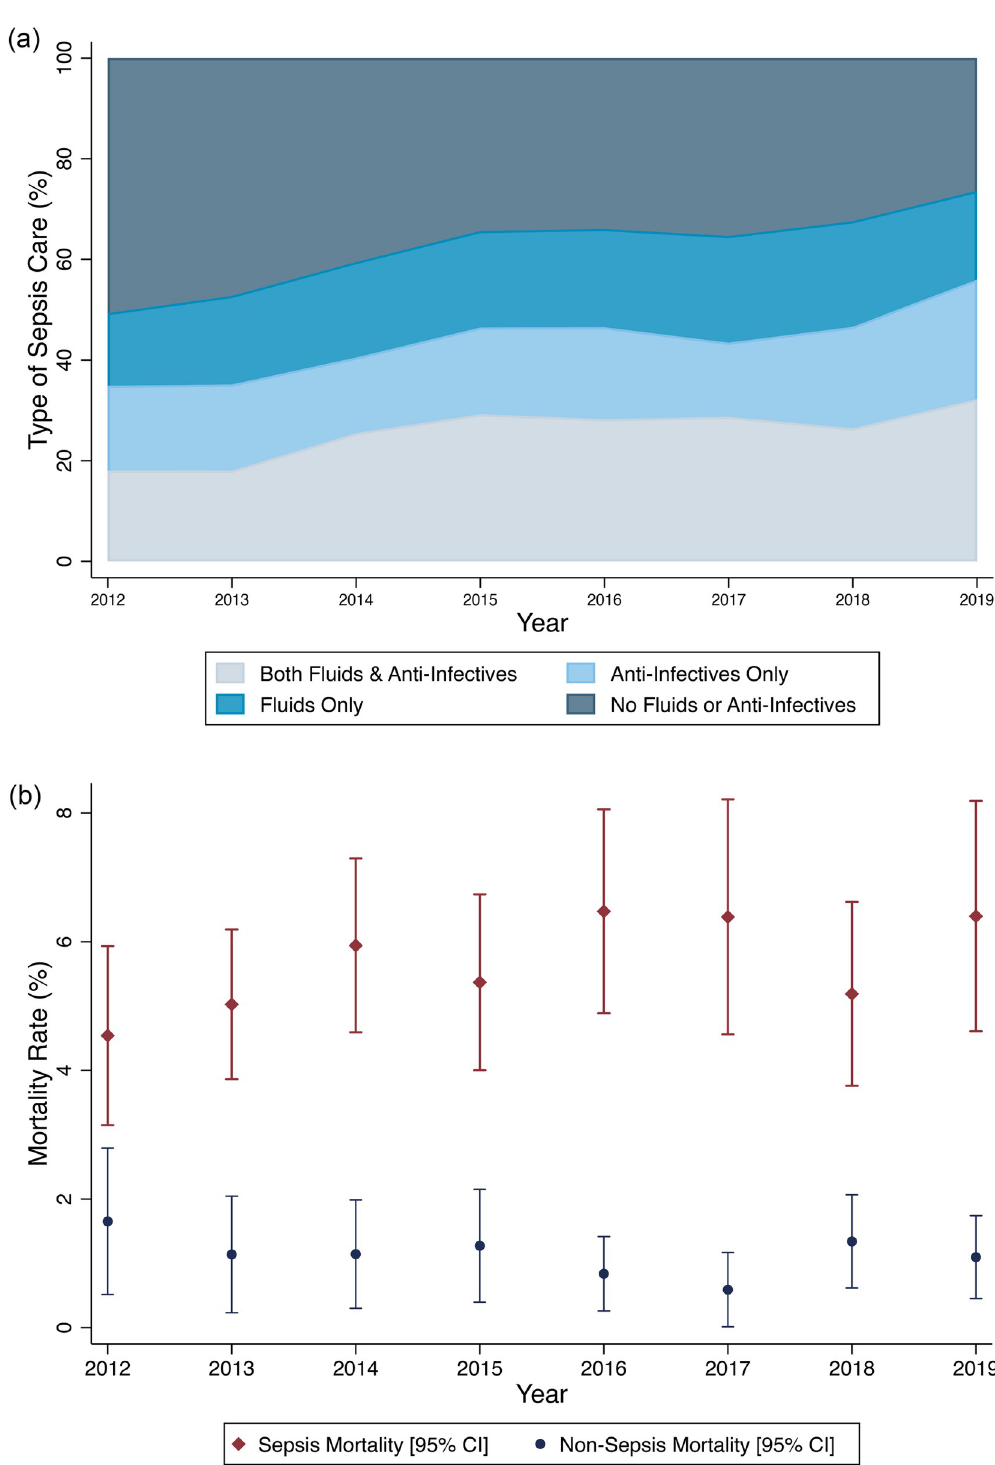
Fig 3. Trends in sepsis management and sepsis mortality, 2012–2019. Top graph shows proportion of sepsis management over time. Bottom graph shows sepsis mortality over time compared with non-sepsis mortality.